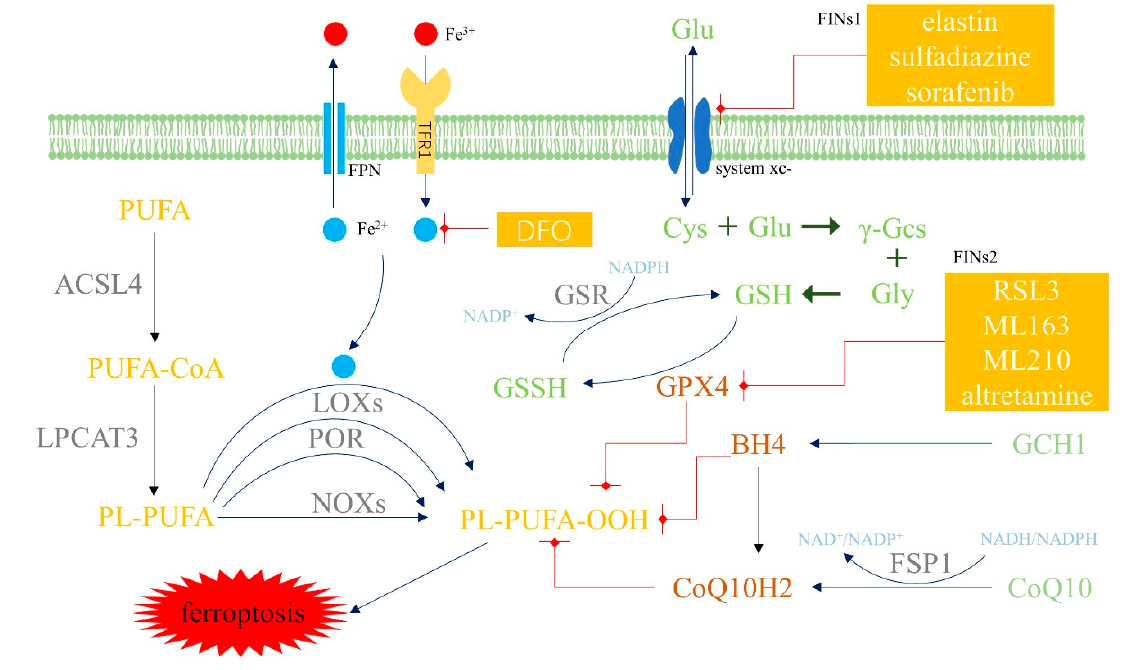
Figure 1. The pathway of ferroptosis.